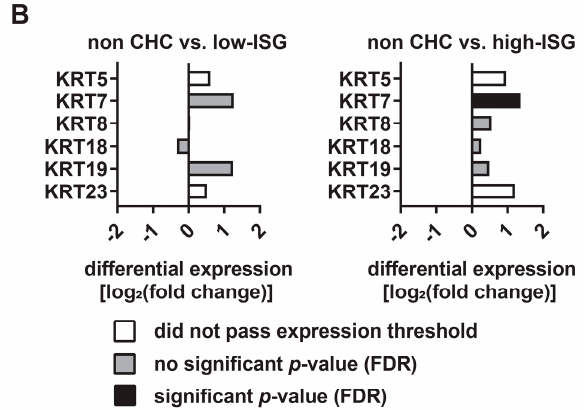
Figure 1. The expression of keratin 23 in primary human hepatocytes varies between different donors. ( A ) Gene expression analysis of keratins in primary human hepatocytes. Shown are the reads per kilobase million (RPKM) values of keratins from seven independent donors. ( B ) Differential expression of keratins in chronic hepatitis C patients (CHC) with low and high interferon-stimulated genes (ISG) induction compared with HCV-negative patients. Depicted are the differential expression of keratins in CHC patients with a low ISG response, compared with HCV-negative patients (left) and the differential expressions of keratins in CHC patients with a high ISG response compared with HCV negative patients (right). (FDR, false discovery rate).